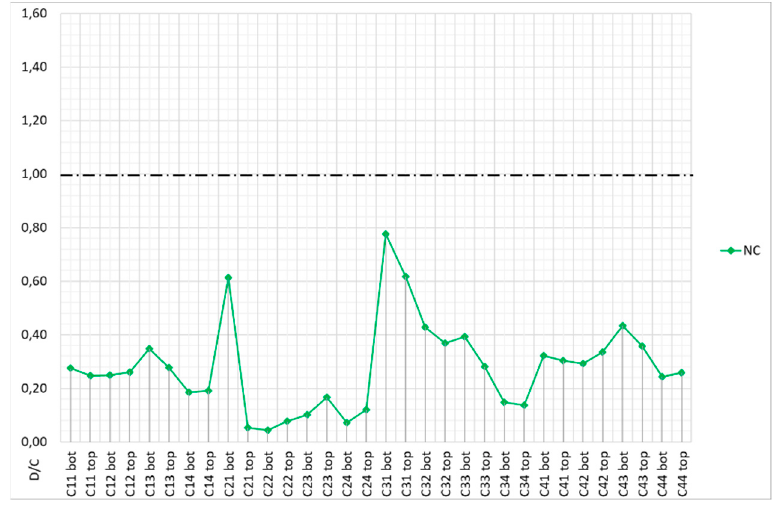
Figure 14. Capacity curves and performance points of the DCM and FINAL.